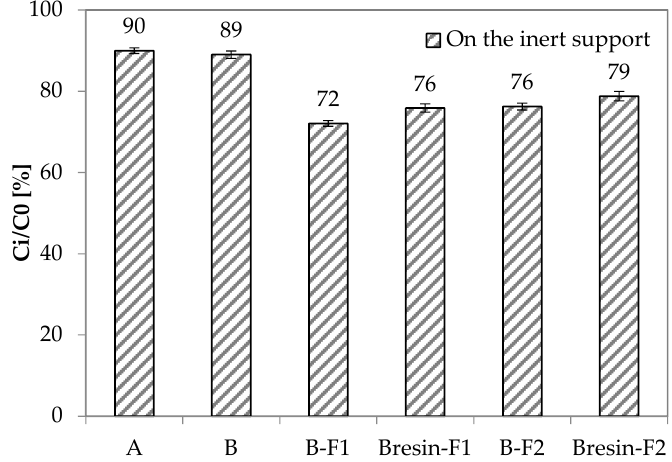
Figure 7. Methyl-ethyl-ketone (MEK) residual concentration Ci/C0 inside the box as a function of exposure time when paints are applied on the inert support.